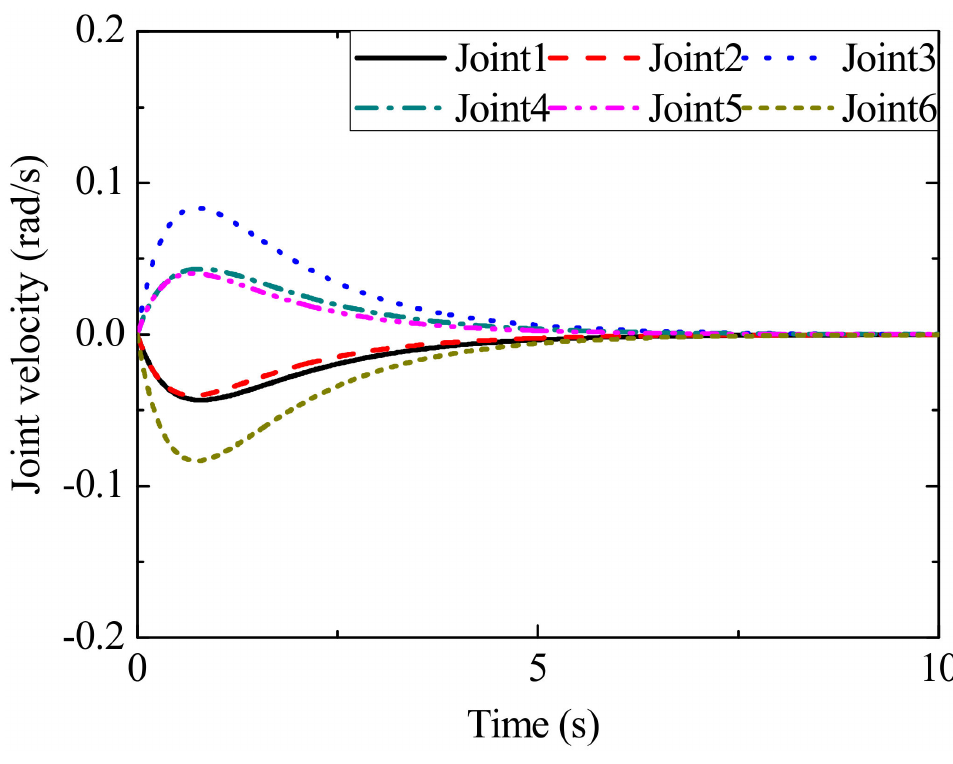
Figure 18. Joint velocities in the trajectory tracking stage.